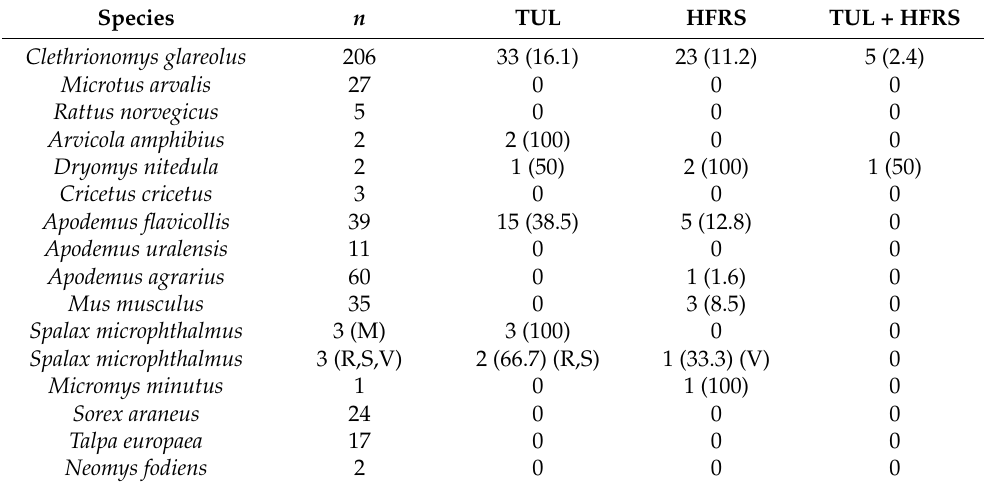
Table 1. Number and proportions of small mammals involved as reservoirs of tularemia and HFRS, 2021–2022. ( n —number of specimens, TUL—number (%) of the positive tests for tularemia, HFRS— number (%) of positive tests for HFRS, TUL+HFRS—number (%) of simultaneous detection of positive tests for tularemia and HFRS, M—Mordovia, V—Voronezh, R—Rostov, S—Stavropol). Species n TUL HFRS TUL + HFRS Clethrionomys glareolus